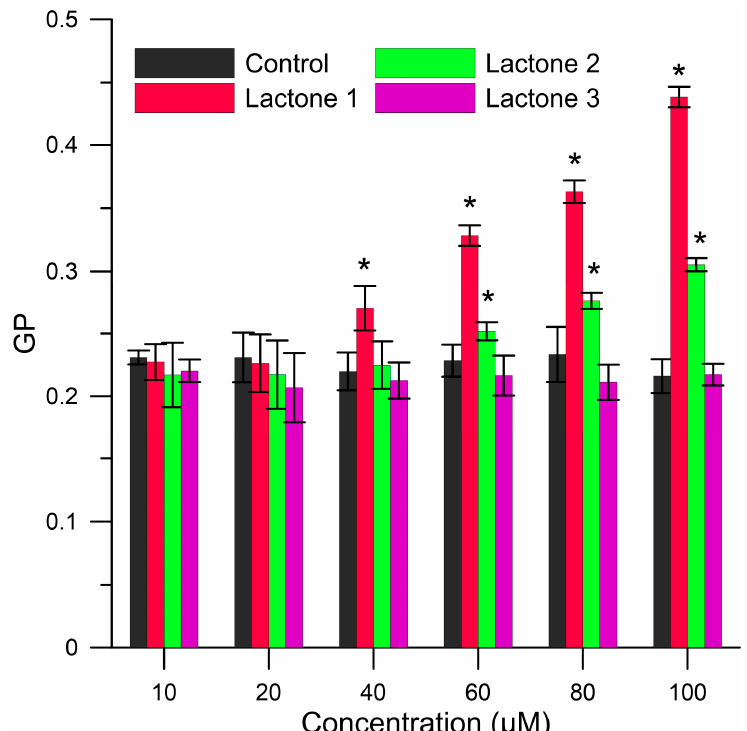
Figure 3. Values of generalized polarization (GP) of Laurdan probe for the red blood cells membranes (RBCMs; control) and RBCMs with addition of lactones 1 – 3 at 37 °C. Values are mean ± Standard Error of the Mean (SEM). Means labeled with asterisk (*) are significantly ( p < 0.05) different from control.